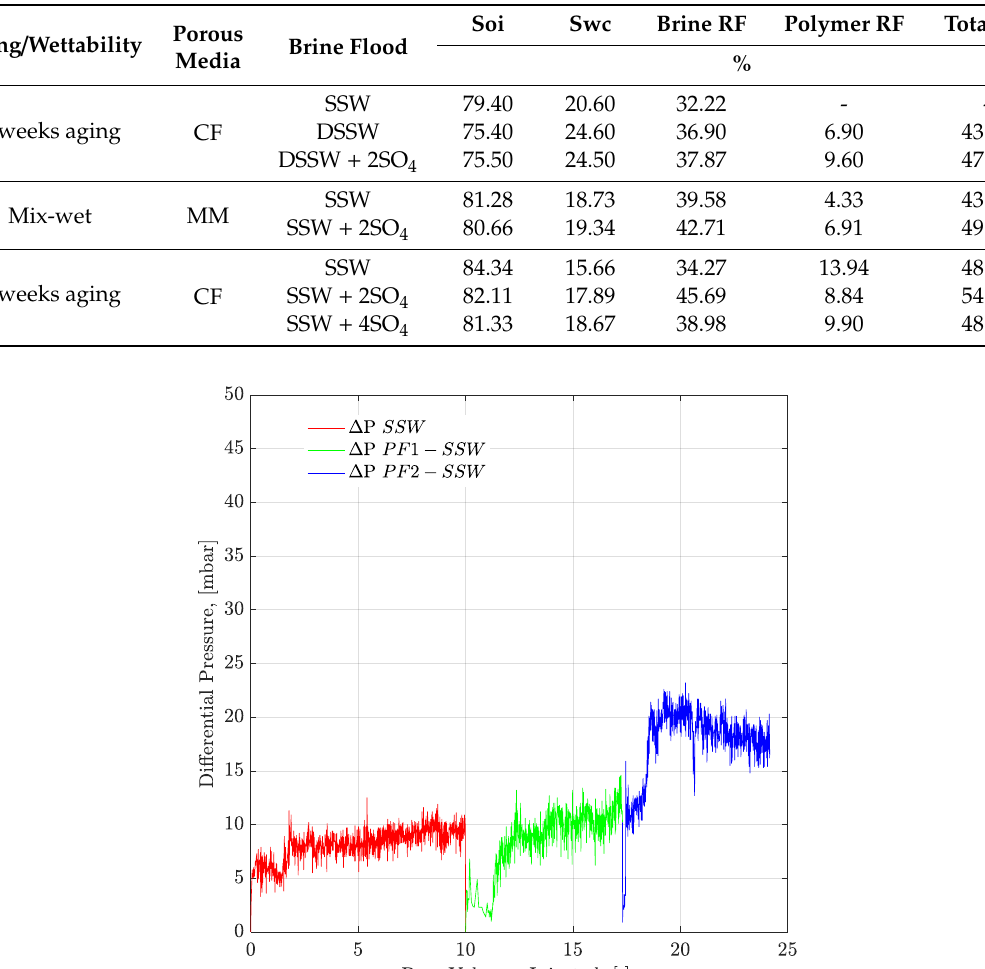
Table 7. Oil recoveries of Core plugs and mix-wet micromodels in secondary mode brine flood and tertiary mode polymer flood.